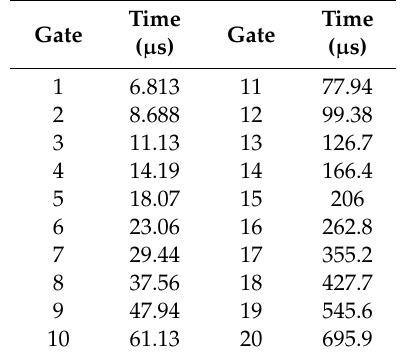
Table A1. Gate center times.